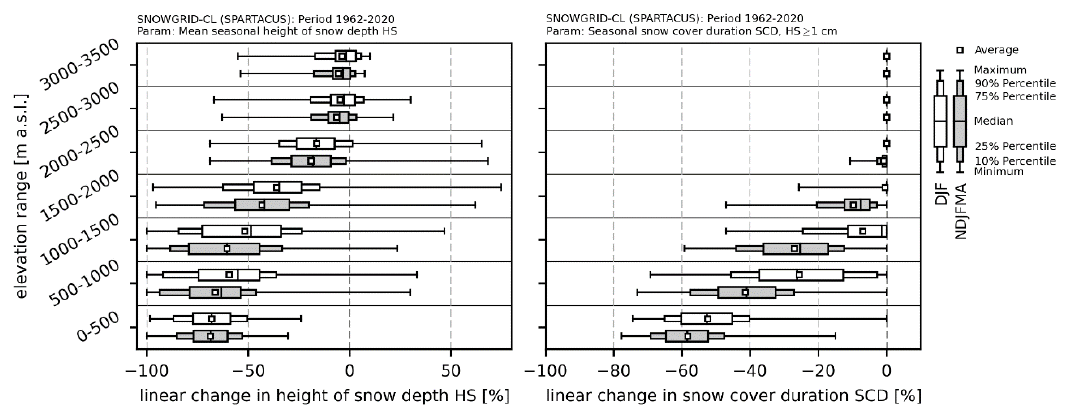
Figure 8. SG-CL calculated, altitude-dependent relative trends (Theil–Sen slope) of seasonal snow depth HS ( left ) and snow cover duration SCD ( right ) in the core (DJF; empty boxes) and extended winter season (NDJFMA; grey boxes) in elevation bins of 500 m for the period 1961/62–2019/20.